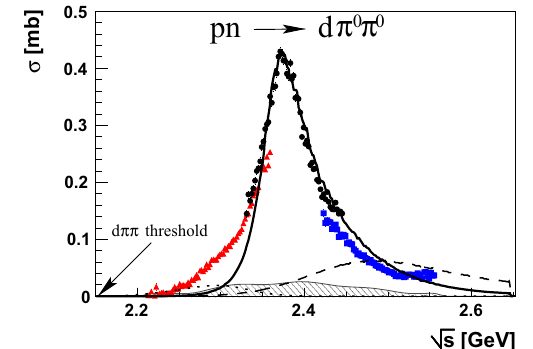
Fig. 1 The d ∗ (2380) dibaryon resonance seen in the pn → d π 0 π 0 reaction reported by the WASA-at-COSY Collaboration